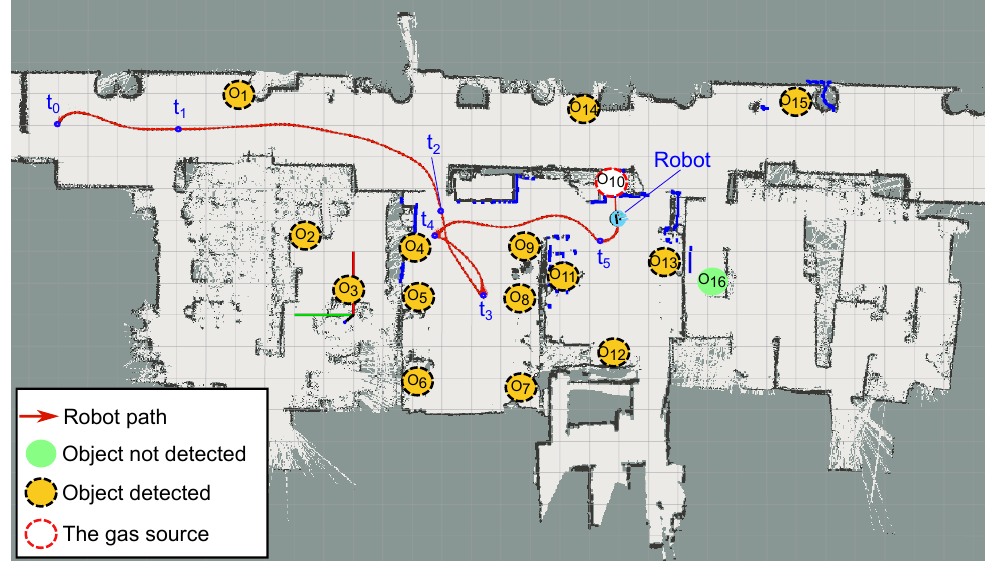
Figure 7. Path followed by the robot while searching for the gas leak (located at Object-10 ) and final state of the different objects considered in the experiment. Different time-instants were analyzed to account for the new discovered objects and estimated